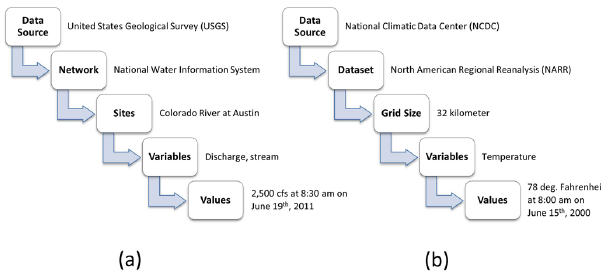
Fig. 5. Conceptual data object model for a (a) 1-D time series and (b) 2-D